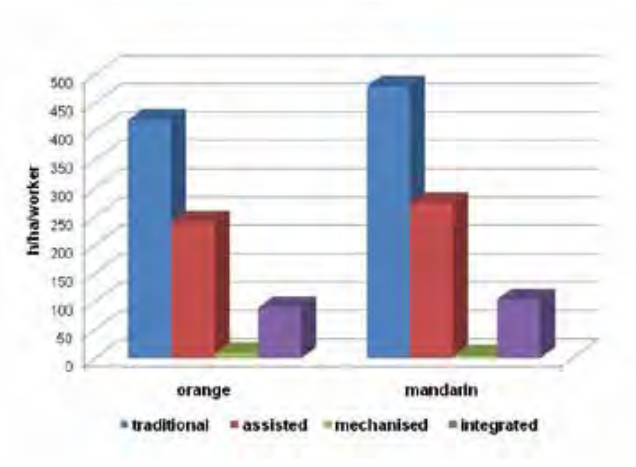
Fig. 10 - Work time in different kinds of